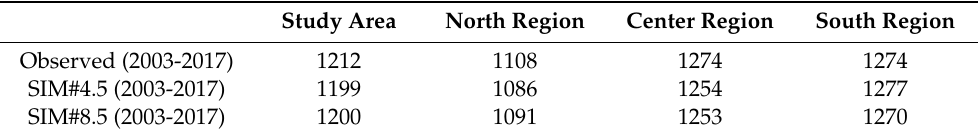
Table 3. Mean annual precipitation [mm yr − 1 ] based on spatially distributed observations and simulated climate.